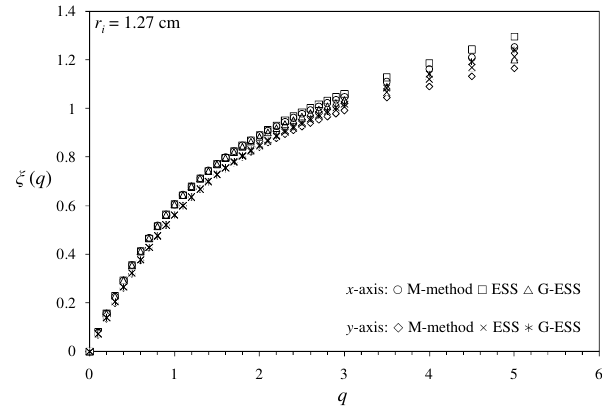
Fig. 8. ξ(q) versus q evaluated for r i =1.27cm on face 1 in x and y